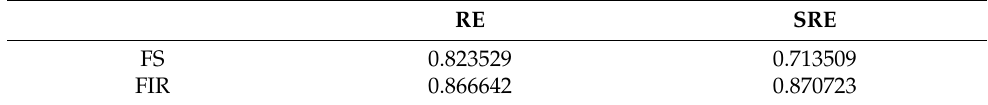
Table 5. The correlation coefficient of FS, FIR, RE and SRE variables.